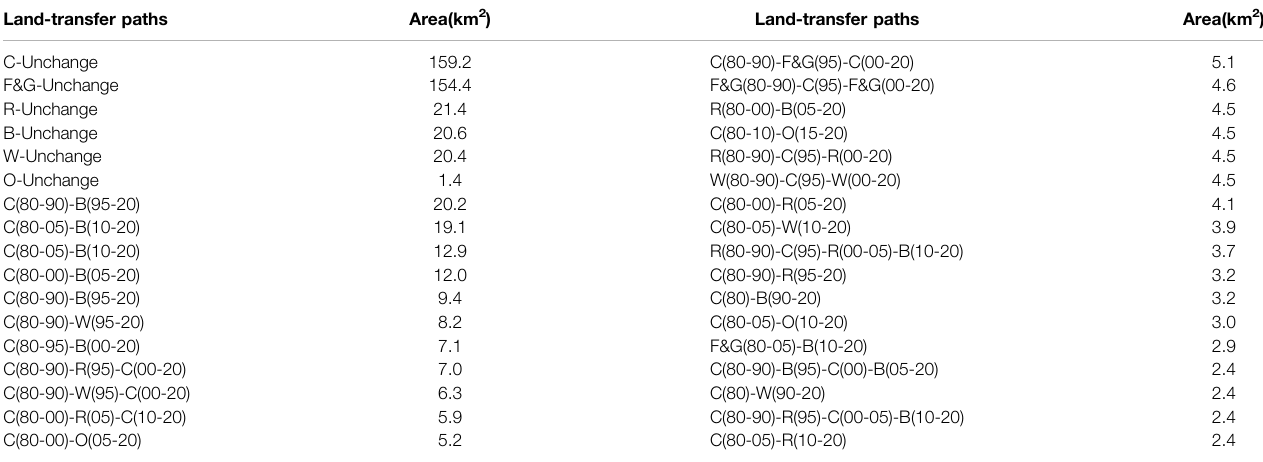
TABLE 2 | Quantities of different land-transfer paths in 1980 – 2020. Land-transfer